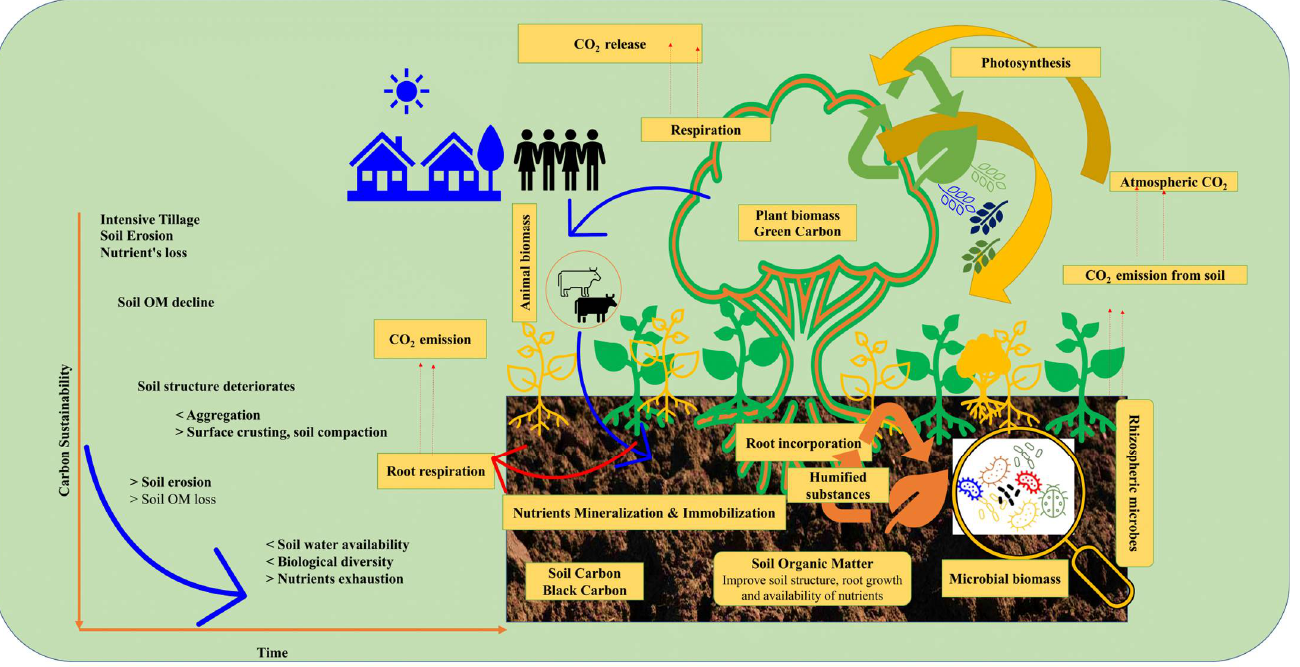
Figure 1. Carbon cycle in the soil–plant–microbes–atmosphere interaction.